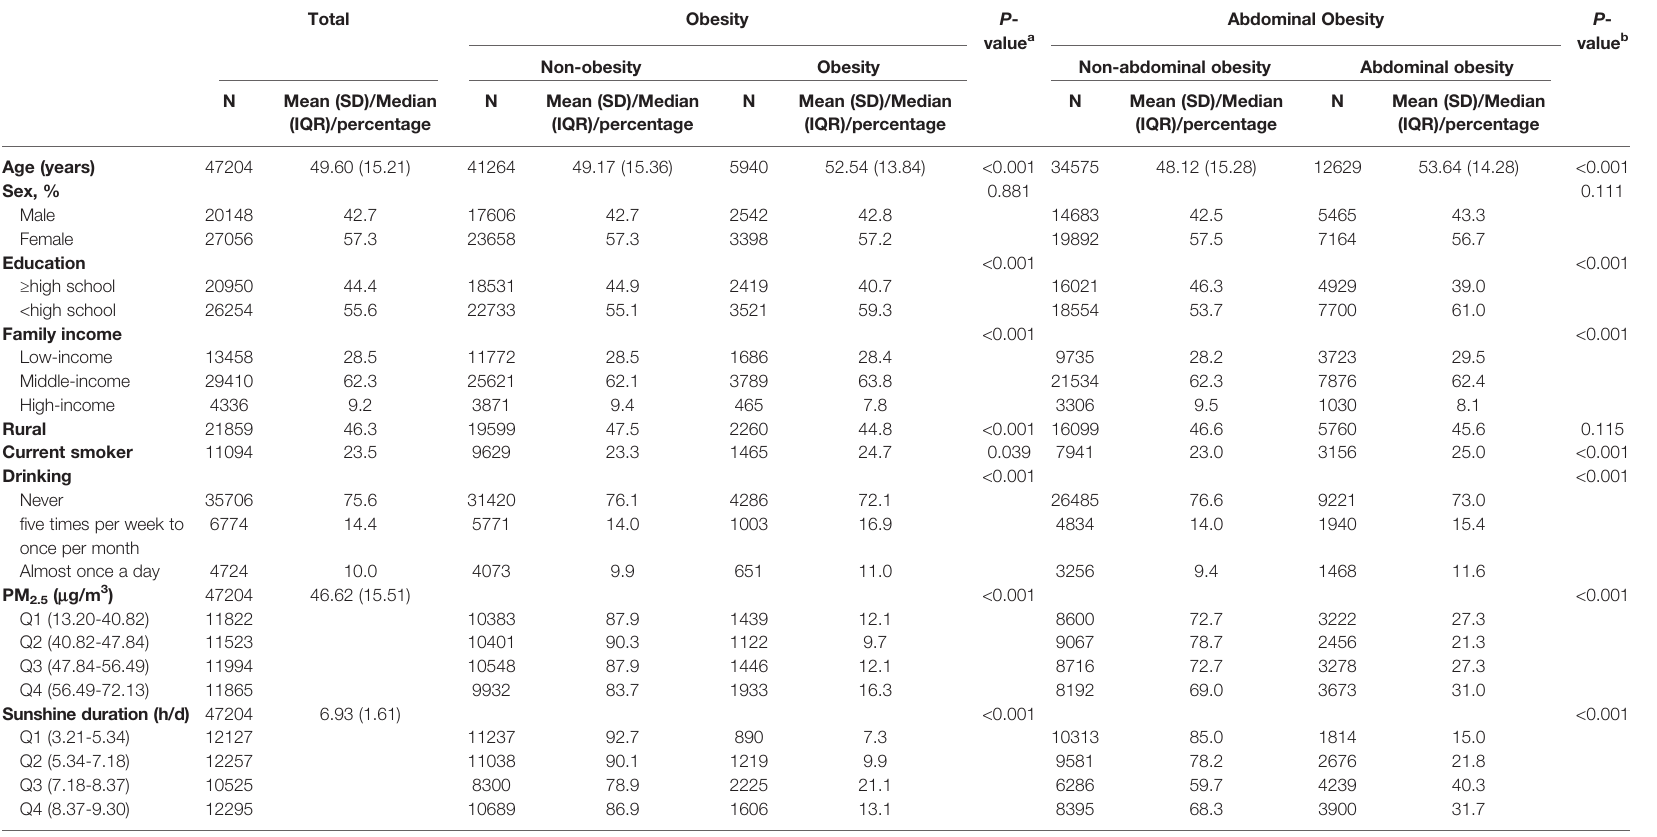
TABLE 1 | Characteristics of the study population strati fi ed by obesity or abdominal